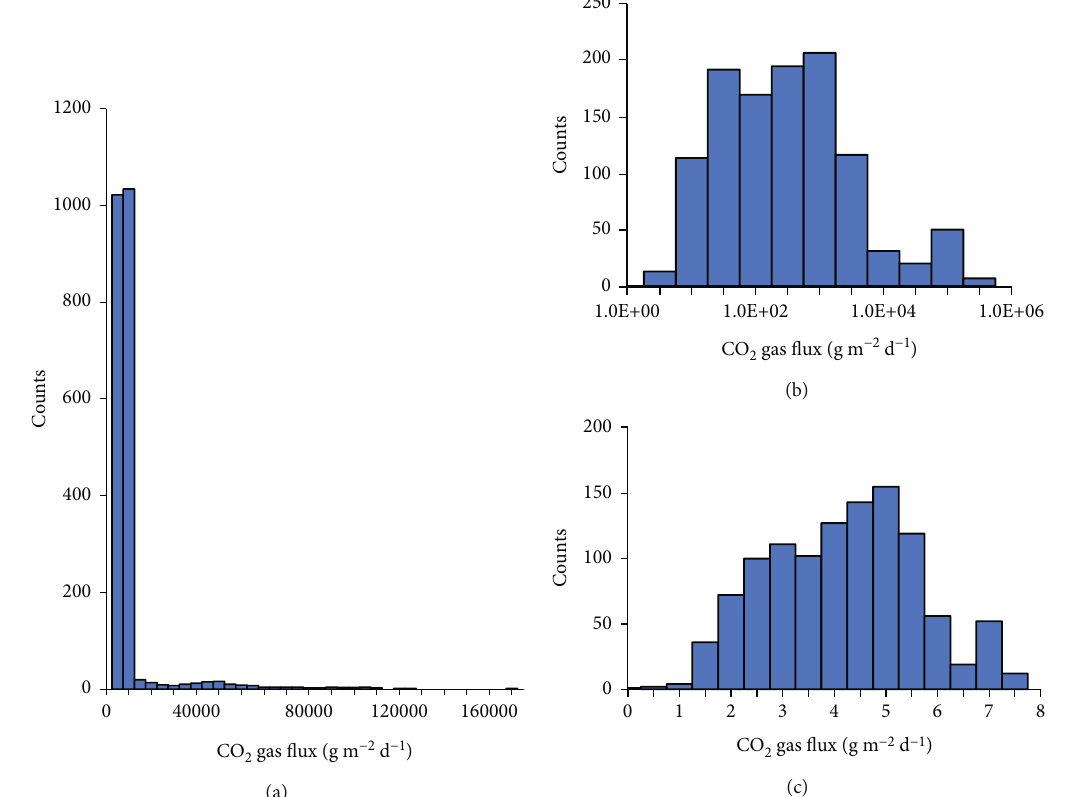
Figure 4: Gas fl ux in gm -2 d -1 : (a) the dataset; (b) displaying the data on a logarithmic scale; and (c) the box-cox transformed dataset with -0,093 as